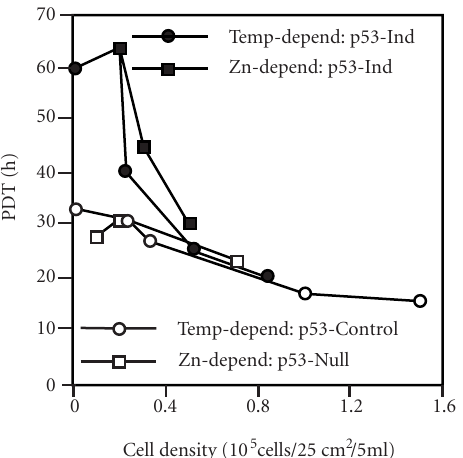
Figure 1: Reconstitution of normal p53 function restores density- dependent growth to immortal cell lines. Population doubling times (PDT) were determined from growth curve analyses, performed at the indicated initial cell densities, for temperature-dependent (closed circles, lines 1h-3 and 1n-3; 25) and Zn -dependent p53- inducible cells (closed squares, lines Ind-5 and Ind-8; 26) and their respective control cells (open circles, lines 1g-1 and 1m-5, 25; open squares, lines Con-2 and Con-3, 26) grown under p53-inducing conditions (32.5 ◦ C and 60 µ M Zn , respectively). Growth curves for temperature-dependent cells were performed in triplicate; growth curves for Zn -dependent cells were performed in duplicate or trip-